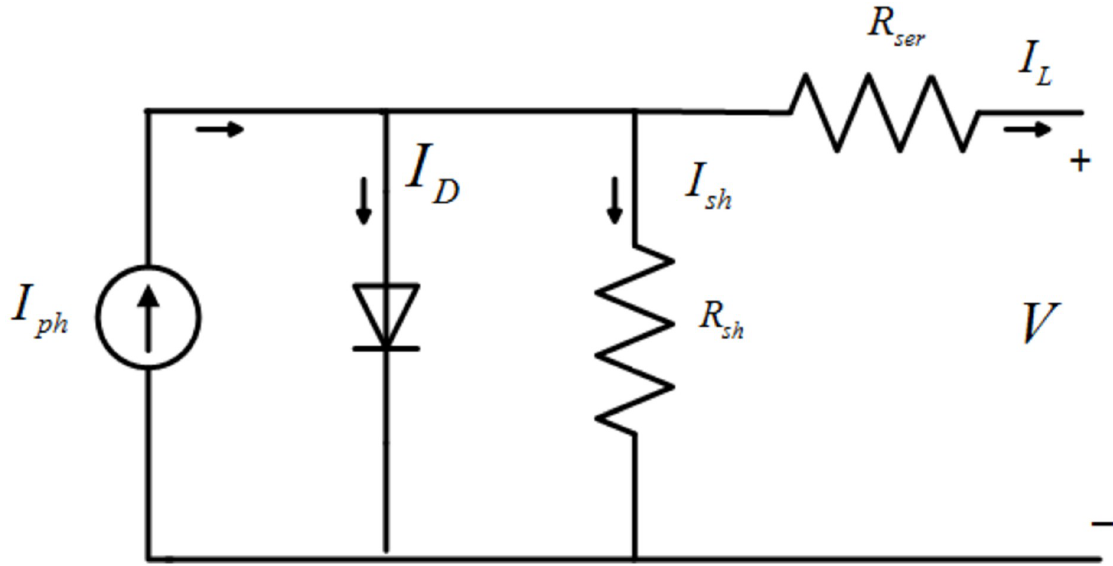
Fig 3. Single diode model of PV